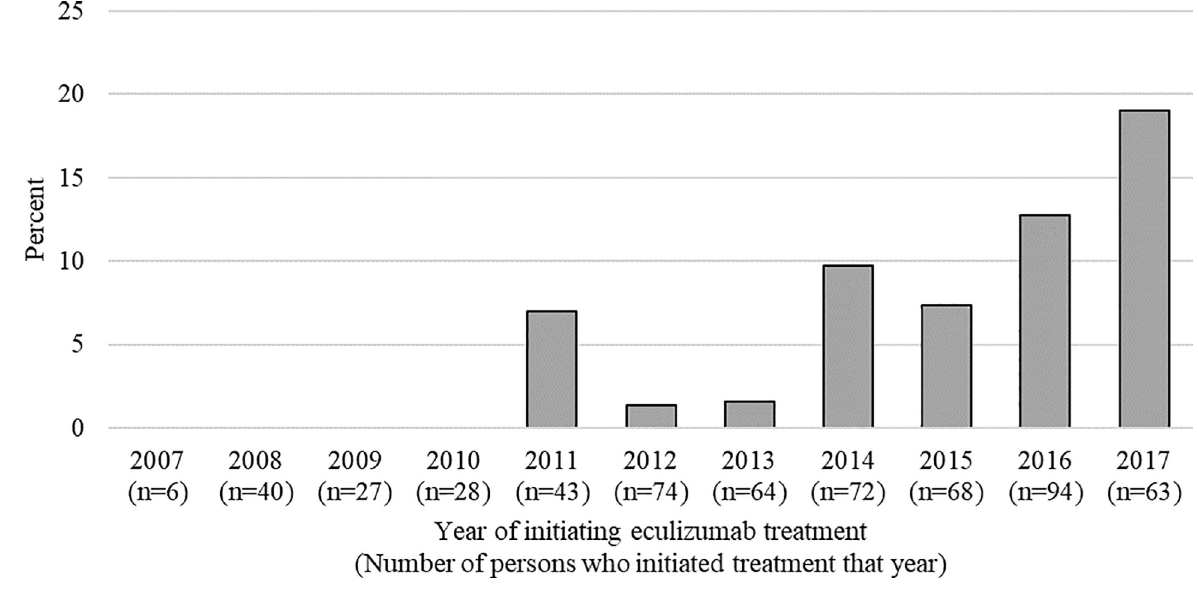
Fig 2. Percentage of eculizumab recipients receiving antibiotics for � 50% of the risk period by year of starting eculizumab treatment, IBM Marketscan Commercial Database, 2007–2017.